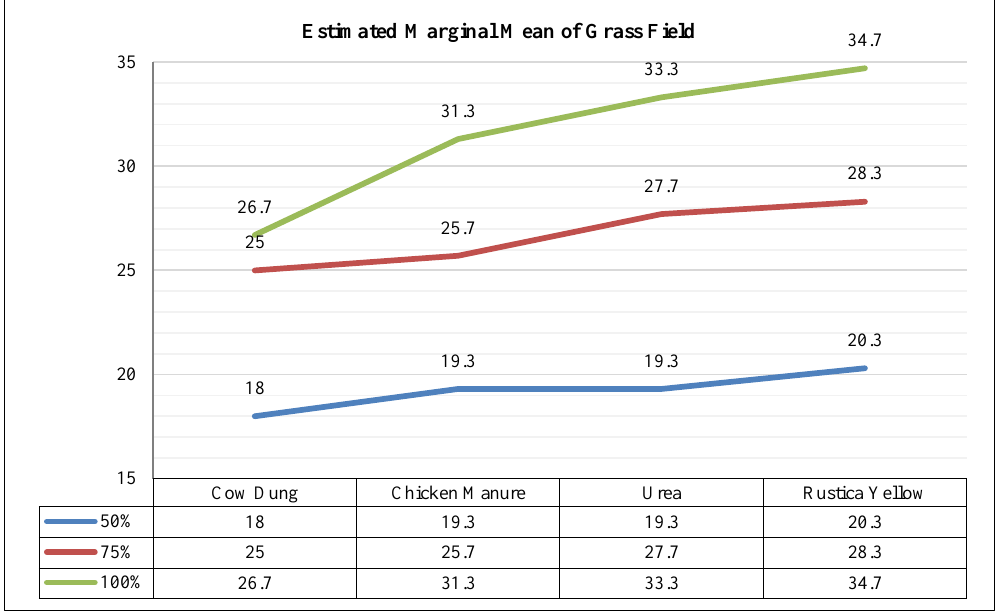
Figure 4. Nitrogen Sources Effect and Levels on the Number of King